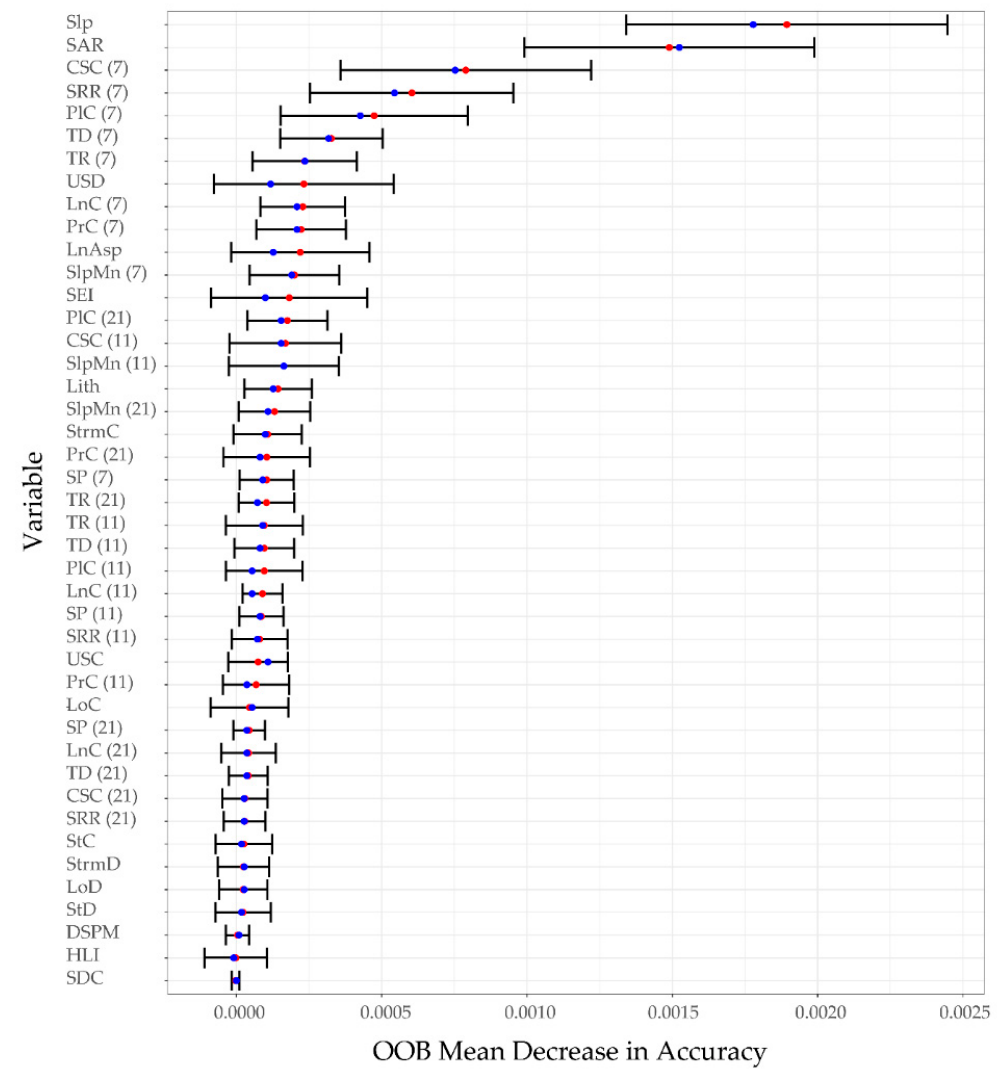
Figure 11. Variable importance calculated using conditional variable importance. Five replicates were used to obtain the standard deviation, as represented here with error bars. The red point represents the mean while the blue point shows the median.